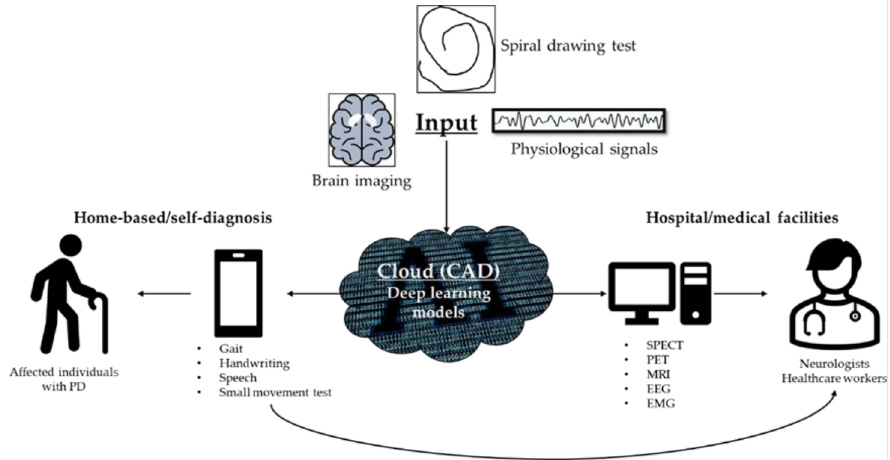
Figure 17. Block diagram of a Cloud-based system for PD diagnosis using various types of inputs from different